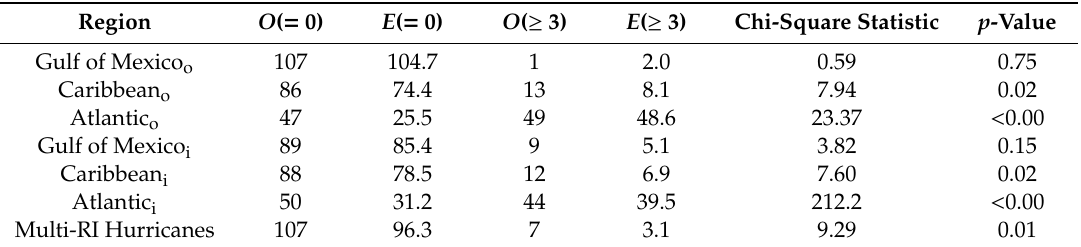
Table 9. Observed (O) and expected (E) number of years with zero hurricanes and with 3 + hurricanes originating (o) and initiating RI (i) within the Gulf of Mexico, Caribbean, and Atlantic sub-basins. Region O ( = 0) E ( = 0) O ( ≥ 3) E ( ≥ 3) Chi-Square Statistic p -Value Gulf of Mexico o 107 104.7 1 2.0 0.59 0.75 Caribbean o 86 74.4 13 8.1 7.94 0.02 Atlantic o 47 25.5 49 48.6 23.37 < 0.00 Gulf of Mexico i 89 85.4 5.1 3.82 0.15 Caribbean i 88 78.5 12 6.9 7.60 0.02 Atlantic i 50 31.2 44 39.5 212.2 < 0.00 Multi-RI Hurricanes 107 96.3 3.1 9.29